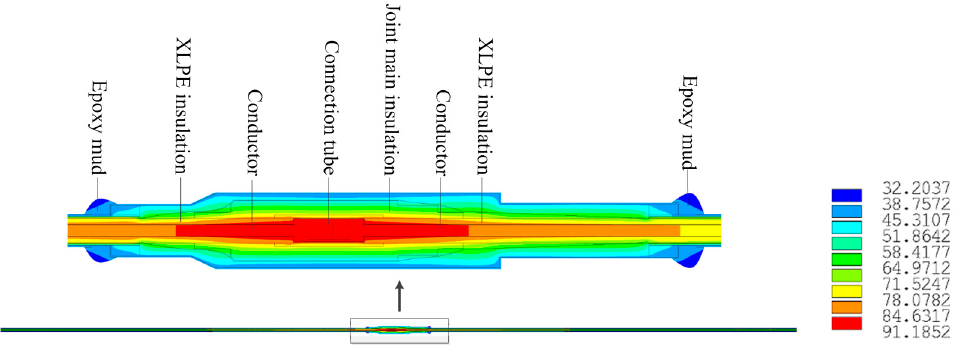
Figure 4. Steady-state thermal field distribution of the cable joint.